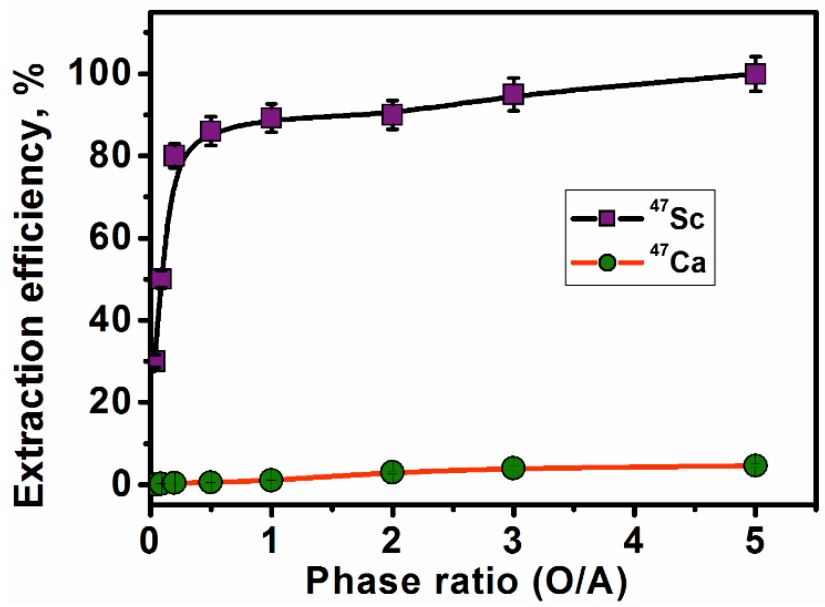
Figure 7. Effect of phase ratio (O/A) on the extraction efficiency of 47 Sc and 47 Ca: pH 1.8; 0.025 M Cyanex 272; extraction time 10 min; 25 ± 1 °C.